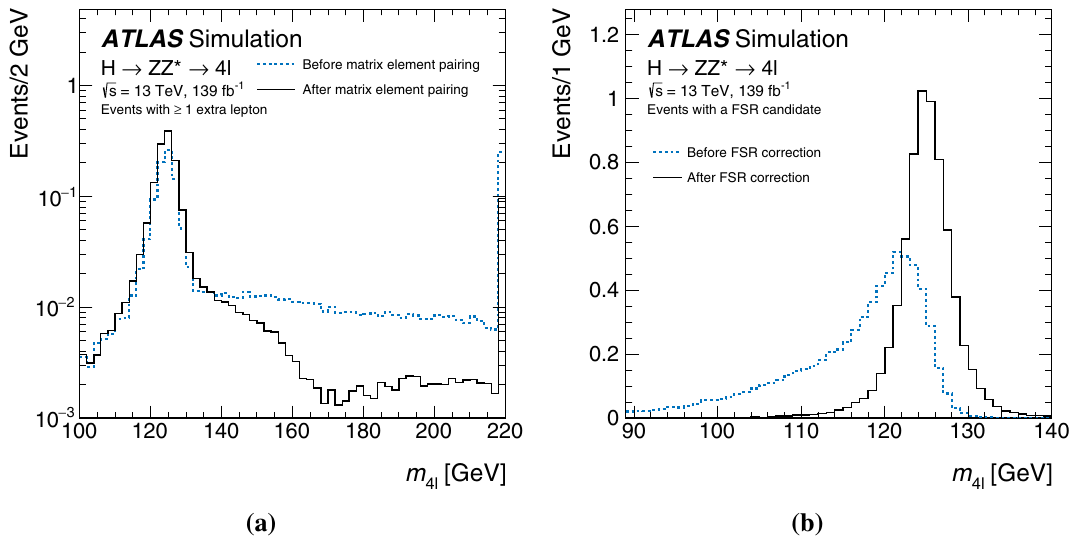
Fig. 2 Impact on the expected invariant mass distribution of the selected Higgs boson candidates due to ( a ) matrix-element-based pair- ing for candidates with at least one extra lepton and ( b ) accounting for